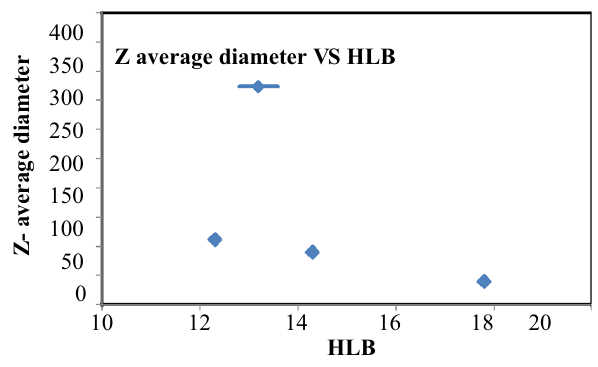
Fig. 3 Relation between Z-average diameters (nm) versus HLB val-